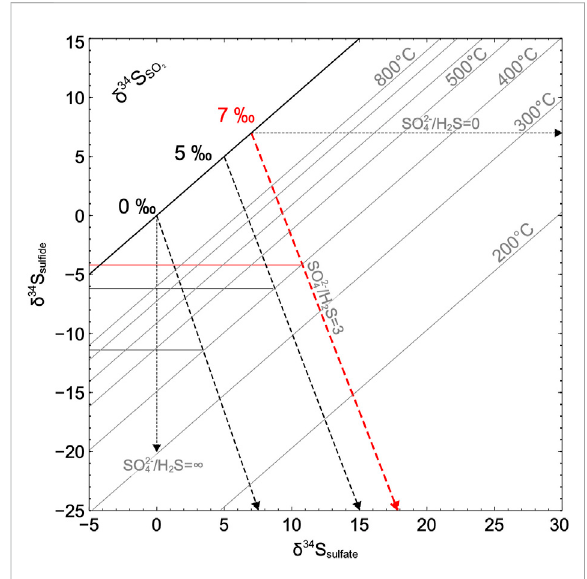
FIGURE 8 Model for the δ 34 S evolution of sul fi des and sulfates, derived from a hydrothermal fl uid primarily consisting of magmatic SO 2 . The isotopic fractionation is related to temperature and the disproportionation of the hydrothermal fl uid. Model adapted after Hutchison et al.